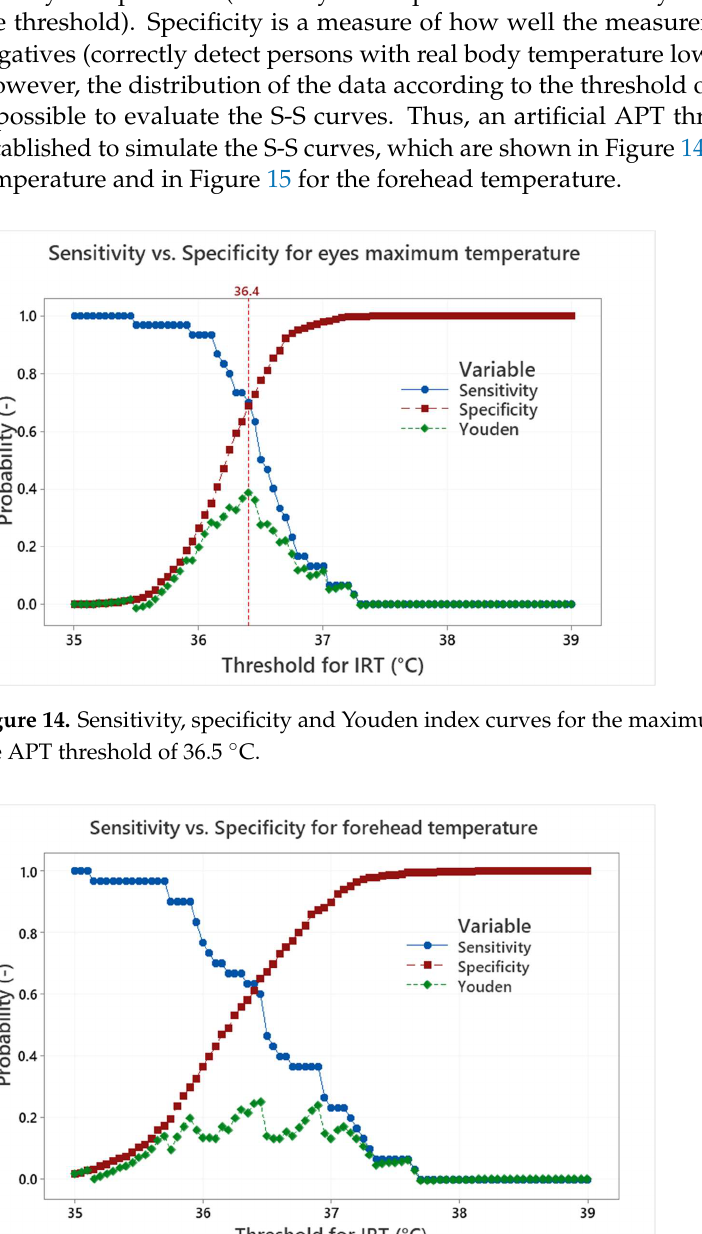
Figure 13. Graphical illustration of true positive (TP), true negative (TN), false positive (FP) and false negative (FN) for the IRT forehead maximum temperature in relation to APT with the thresh- old 37 °C.